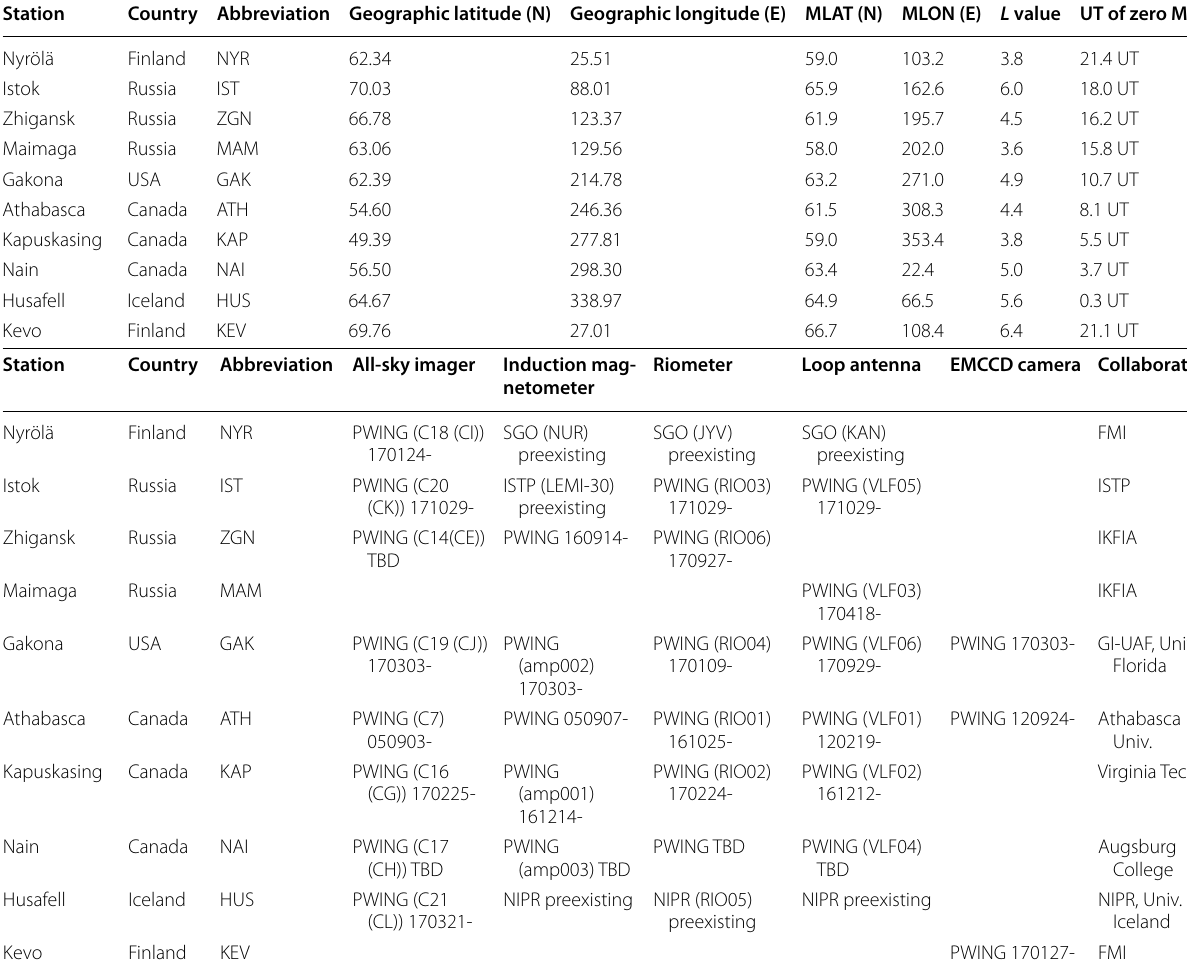
Table 1 Geographic and geomagnetic coordinates of the PWING stations, instruments with their start dates in year/ month/day (yymmdd), and local